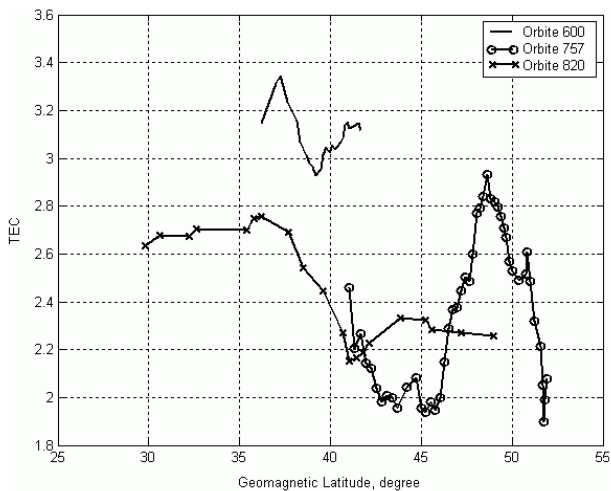
Fig. 4. TEC variations vs. geomagnetic latitude for three sample orbits. Errors of TEC determination are the same as for Fig.